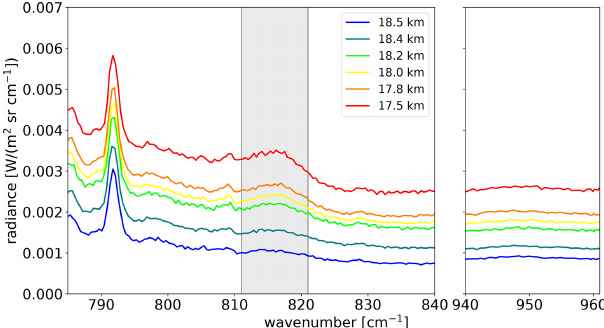
Figure 12. Example infrared spectra measured by CRISTA-NF dur- ing RECONCILE flight 3 inside PSCs at about 12:10UTC. The spectra at different tangent altitudes are shown using colour coding. The grey bar marks the region of the shifted NAT